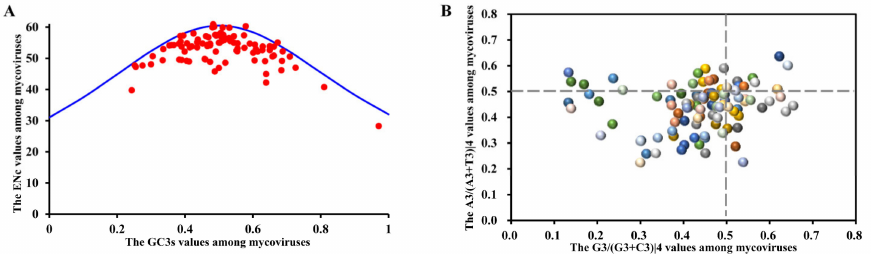
Figure 3. The ENc-GC3s plot ( A ) and Parity Rule 2 plot ( B ) of all mycoviruses. ( A ) The ENc-GC3s plot. The x -axis represents the GC3s (the frequency of the third nucleotides G + C in the synonymous codons) values of mycoviruses, and the y -axis represents the calculated ENc (the effective number of codons) values among mycoviruses. Each red point corresponds to one mycovirus, the solid blue line represents the expected ENc value when codon usage is only determined by GC3s composition. ( B ) The Parity Rule 2 plot. The x -axis represents the G3/(G3 + C3)|4 (the content of the third codon position of the four-codon amino acids) values, and the y -axis represents the A3/(A3 + T3)|4 values. Each three-dimensional ball represents a mycovirus, the color of the three-dimensional ball is automatically colored according to the corresponding data, and the intersection of gray dotted lines is the